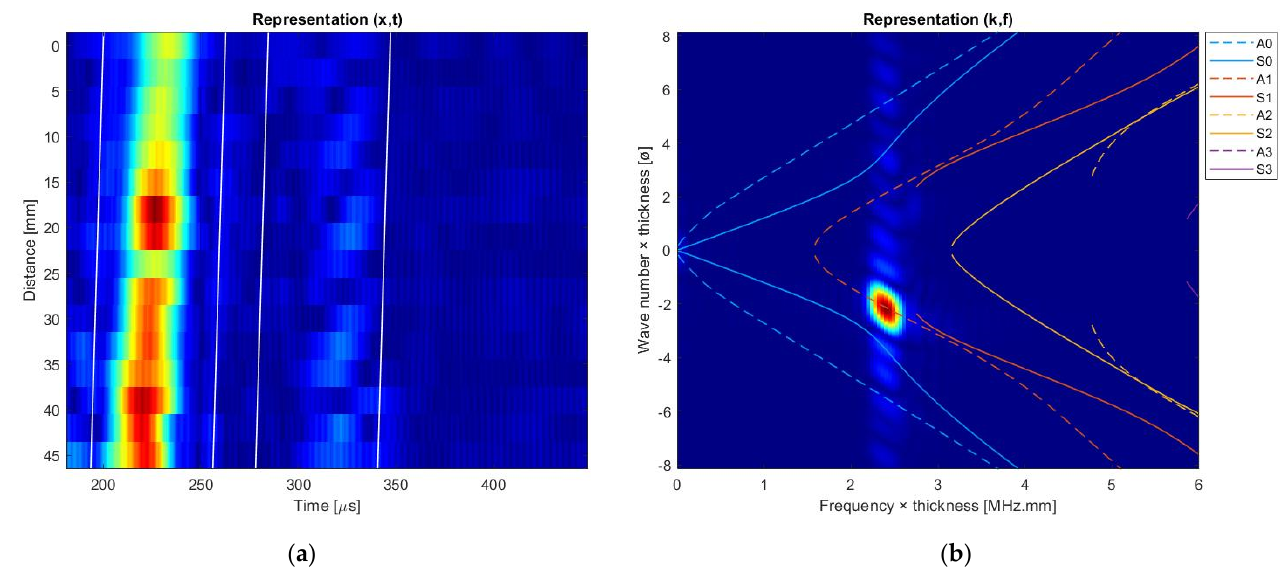
Figure 11. ( a ) Envelope of the signals recorded by each element of the linear array—(x,t) representation; ( b ) 2D-FFT of the first wave packet—(k,f) representation.